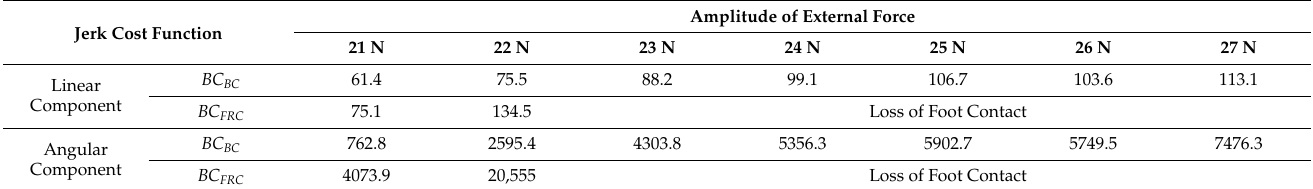
Table 4. Jerk cost functions with different amplitudes of